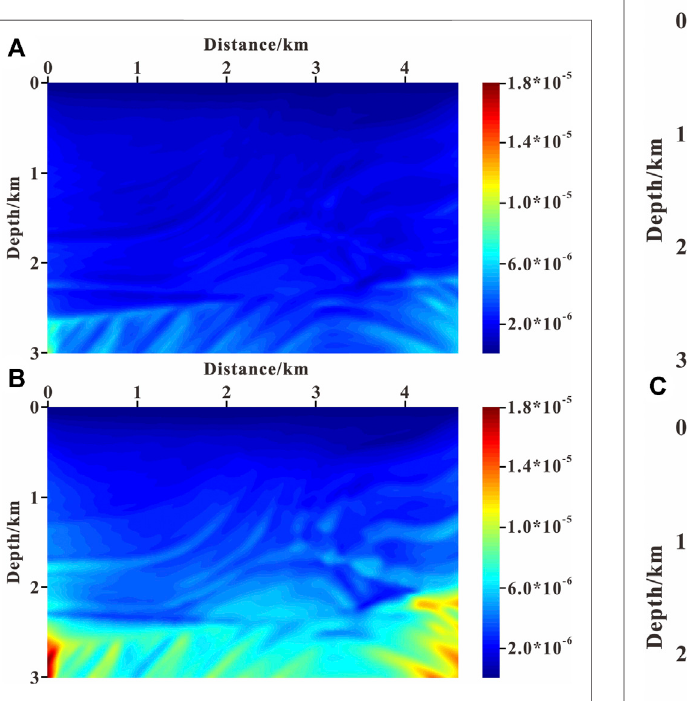
FIGURE 5 | Schematic description of the gradient preconditioning operator: (A) GPSWE; (B) GPTWE.